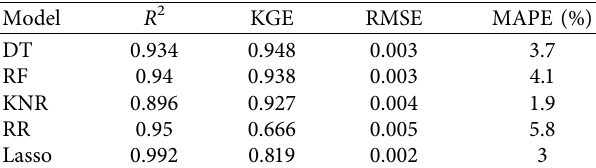
Table 1: Te calculated performance metrics for the gas fow fracture porosity over the testing phase. Model R 2